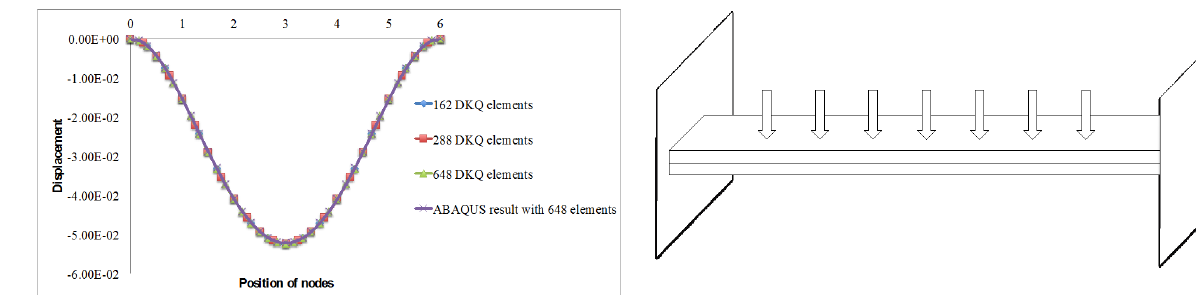
Figure 10: Problem setup of two rectangular shells coupled to-